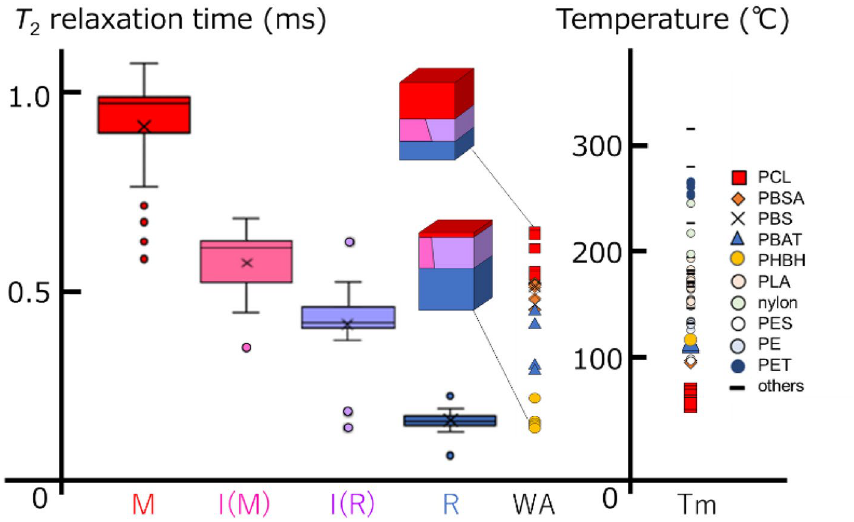
Figure 3. Diagram of polymer properties with T 2 relaxation time among four domain components and melting temperature. M: Red box plot; Mobile, I(M): Pink box plot; Intermediate (Mobile), I(R): Violet box plot; Intermediate (Rigid), R: Blue box plot; Rigid, WA: Weighted average, T m : Melting temperature. x: Average T 2 relaxation time. The box and whisker plot displays the minimum, first quartile, median, third quartile, maximum, and outliers. The estimated domain proportion models were inserted for the highest PCL and lowest PHBH of WA.